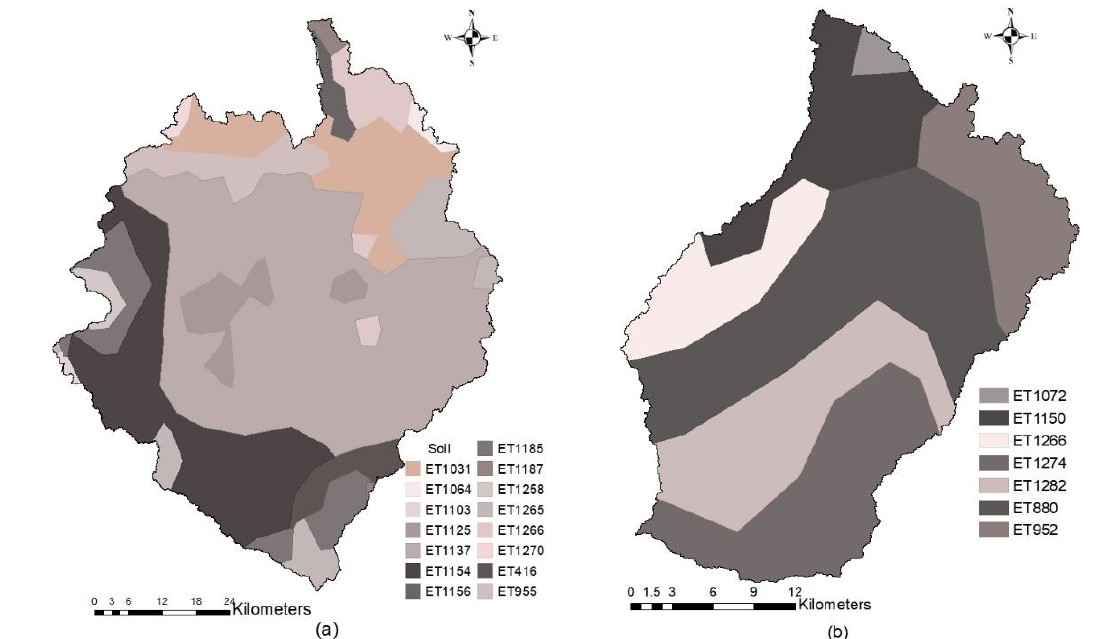
Figure 3. Soil map used at the ( a ) Melka Kunture and ( b ) Keleta sub-basins.